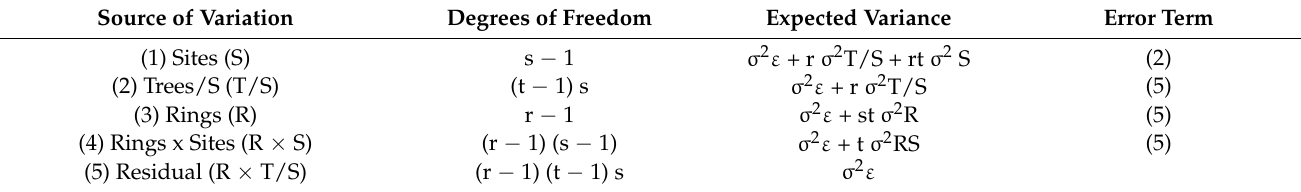
Table 2. Model used for analysis of variance for the ring width and wood density components. Source of Variation Degrees of Freedom Expected Variance Error